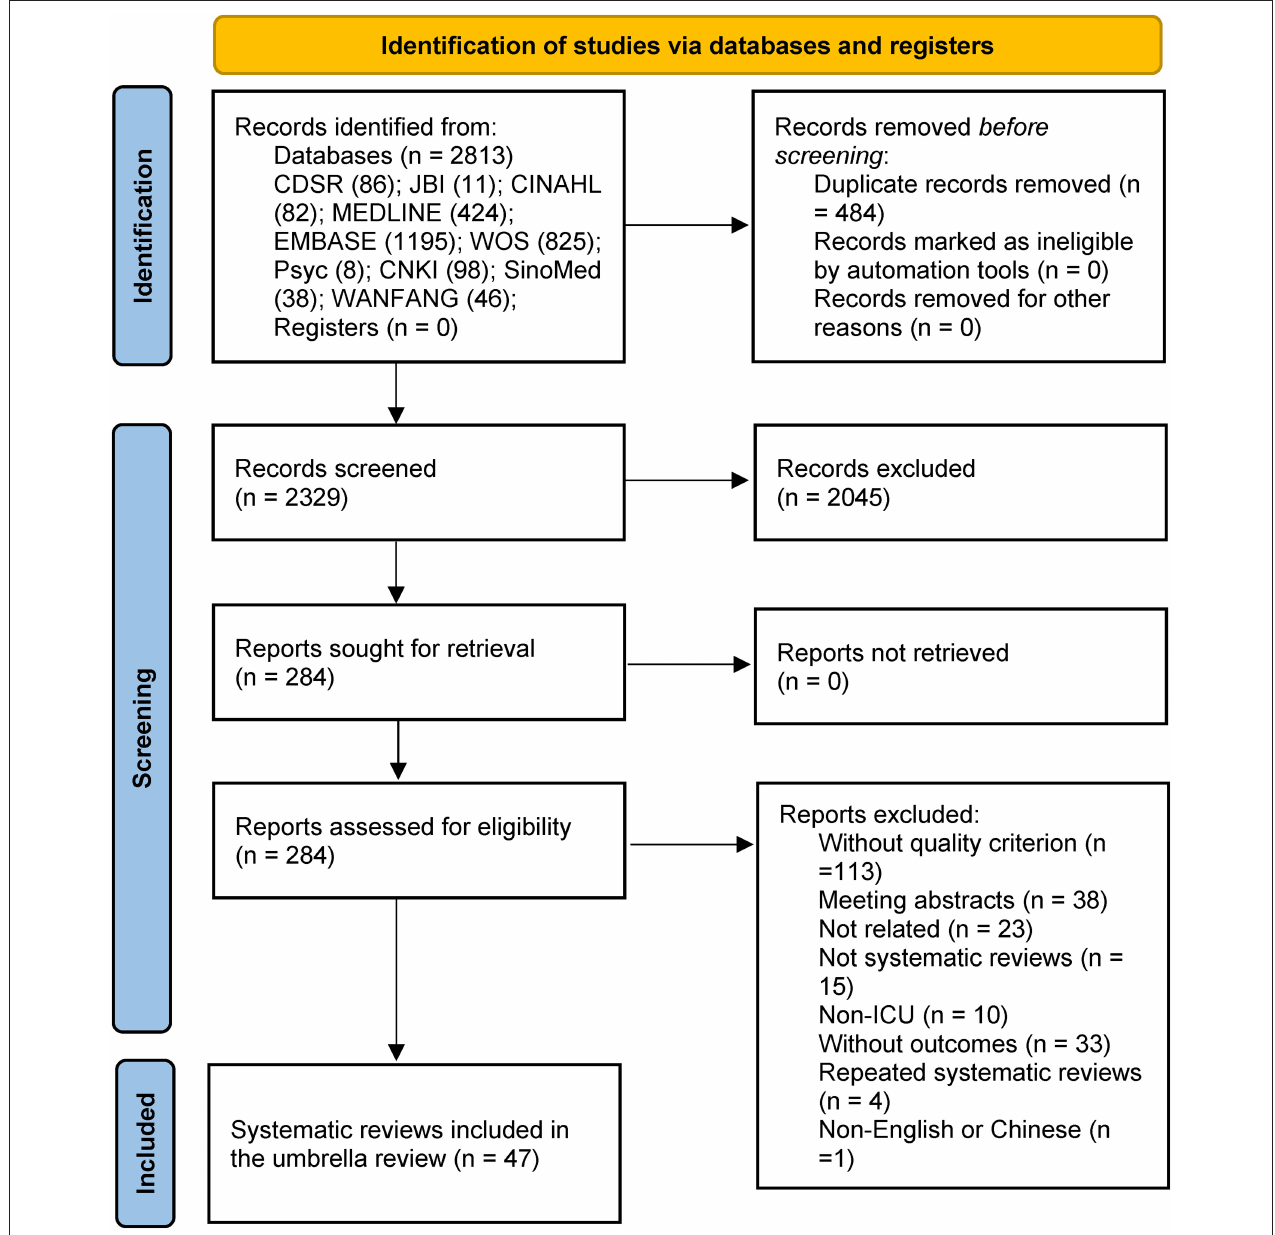
FIGURE 1 | PRISMA 2020 flow diagram for new systematic reviews which included searches of databases and registers